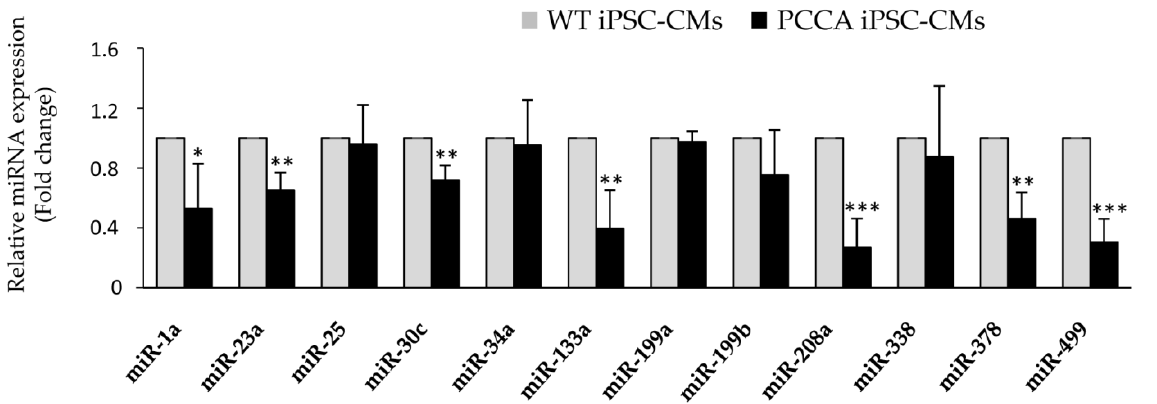
Figure 2. Analysis of miRNA expression in WT and PCCA iPSC-CMs. Relative expression levels of miR-1a, miR-23a, miR-25, miR-30c, miR-34a, miR-133a, miR-199a, miR-199b, miR-208a, miR-338, miR-378 and miR-499 are evaluated by qRT-PCR in iPSC-derived cardiomyocytes. Data represents mean ± standard deviation of three independent cardiomyocyte differentiation triplicates at least. Statistical significance is determined by the Student’s t -test. * p < 0.05; ** p < 0.01; *** p < 0.001.